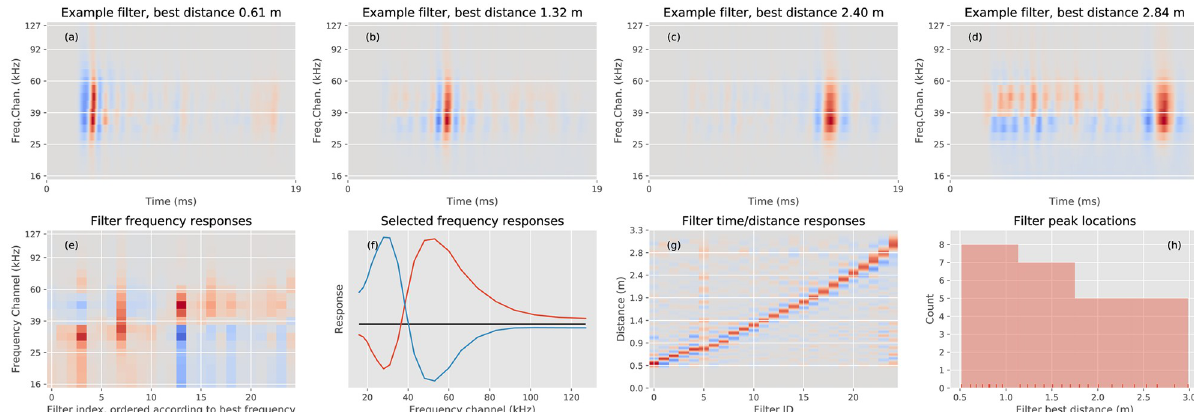
Fig 3. The basic components and their properties. a-d Selected examples of independent components. e The frequency response of the 25 components (ordered according to most sensitive frequency). For each component, its time-average as a function of frequency is plotted. f The frequency response of two selected components (i.e., two columns from panel e ). g The temporal response of the 25 components (ordered according to most sensitive delay or distance (=343 × delay /2), with speed of sound 343m/sec). For each component, its frequency-average as a function of distance (time) is plotted. h Histogram of the best distances (times) of the 25